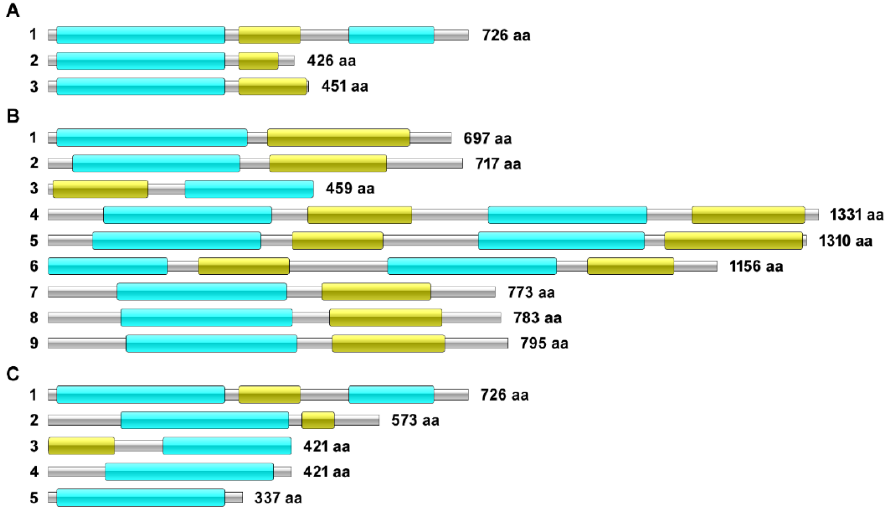
Figure 2. Protein isoforms of the TERG_04309 gene and their orthologs. ( A ) Protein isoforms of the TERG_04309 gene. ( A1 ) Protein from conventionally processed isoform. ( A2 ) Protein from alternative isoform (intron-3 retention). ( A3 ) Protein from alternative isoform (intron-4 retention). ( B ) Orthologs of TERG_04309 protein in other species. (B1 ) T. interdigitale MR816 18 (H109_06718). ( B2 ) T. mentagrophytes TIMM 2789 (TMEN_7207). ( B3 ) T. soudanense CBS 452.61 (H105_04551). ( B4 ) Nan- nizzia gypsea CBS 118893 (MGYG_04329). ( B5 ) Microsporum canis CBS 113480 (MCYG_07490). ( B6 )